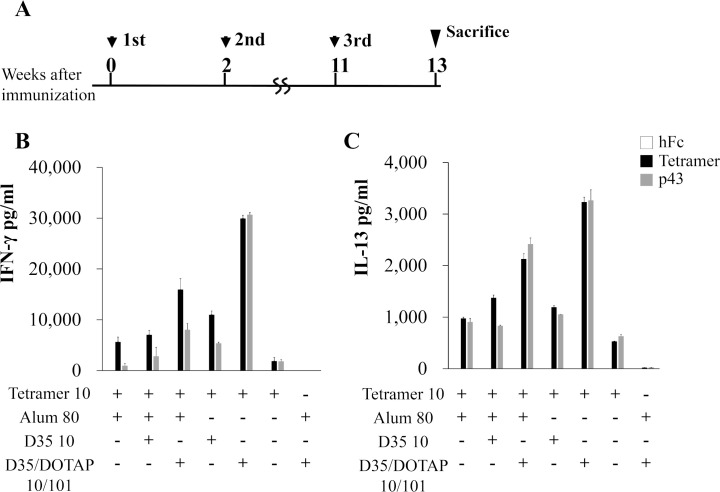
Cellular immunity induced by immunization with the tetramer.(A) Immunization schedule indicated as the weeks of immunization of four-week-old female BALB/c mice (n = 5). At the 13 weeks after the third immunization, single cell suspensions were prepared from the mouse spleens after the hemolysis of red blood cells. The productions of IFN-γ (B) and IL-13 (C) in the supernatant in response to the stimulation of indicated proteins were measured by ELISA assays.